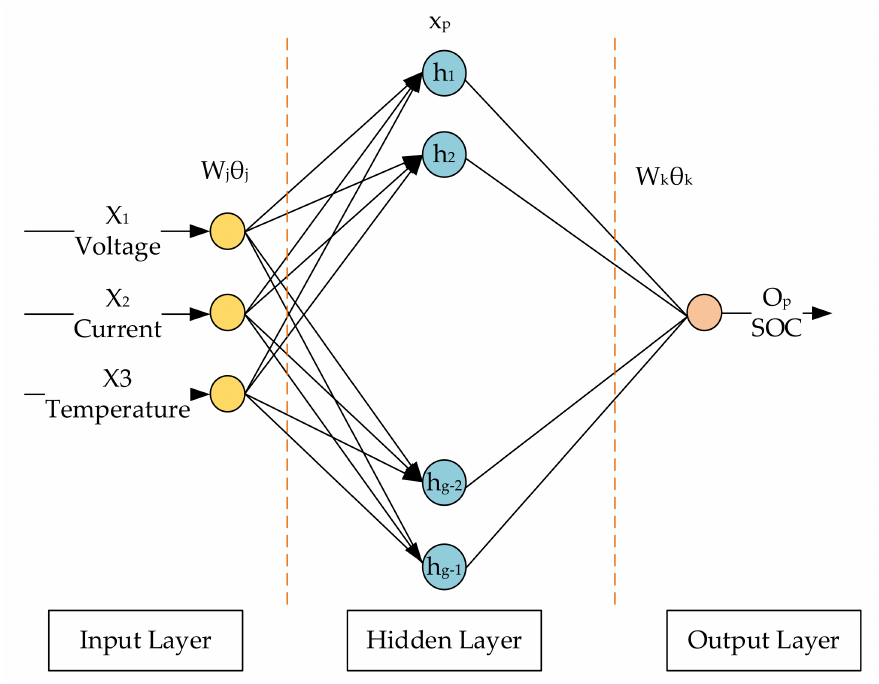
Figure 5. The general architecture of the three-layer neural network for SOC